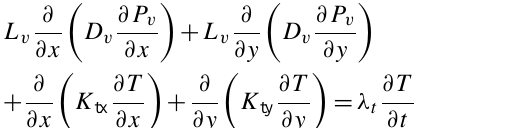
Figure 2b. Thermal properties of the Beaver Creek Sand (Gitirana et al. 2005)